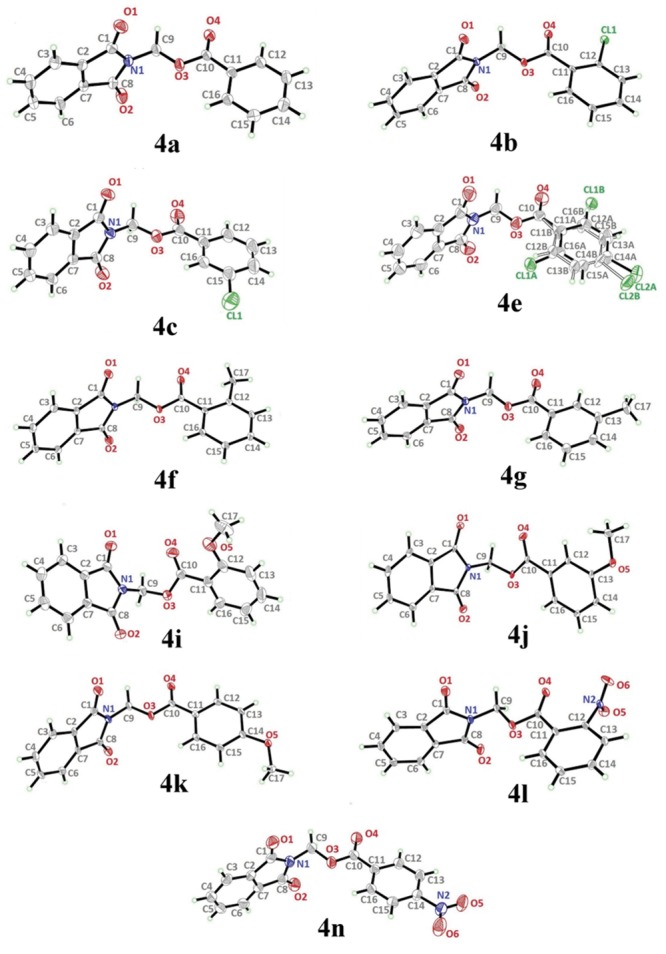

ORTEP diagram of compounds 4a to 4n (excluding 4d, 4h and 4m).Compounds 4b, 4f, 4g, 4j, 4k and 4n are drawn at 50% ellipsoids for non-hydrogen atoms and the remaining compounds are drawn at 30% ellipsoids for non-hydrogen atoms.